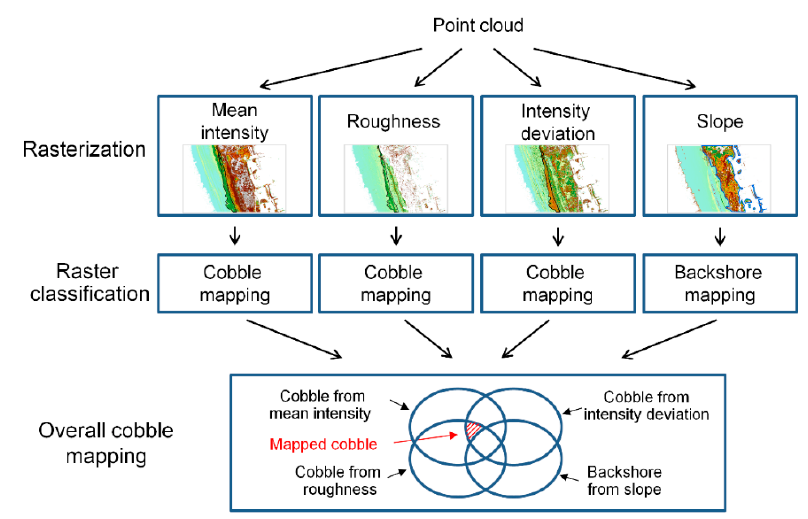
Figure 4. Flowchart of the automated cobble mapping method.